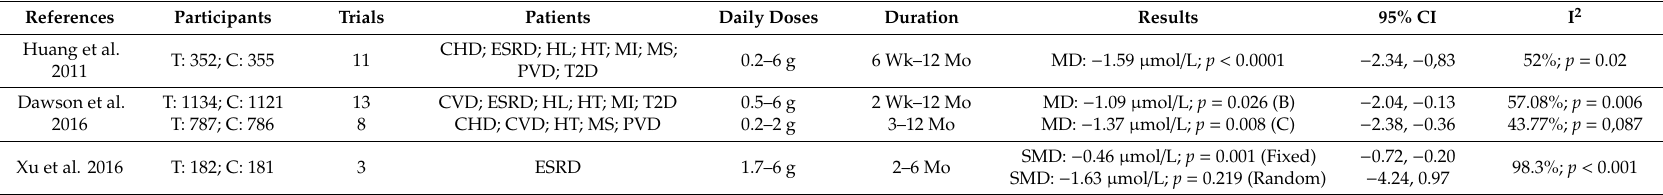
Table 1. E ff ect of omega-3 polyunsaturated fatty acids on homocysteine levels in humans, pooled from meta-analyses of intervention